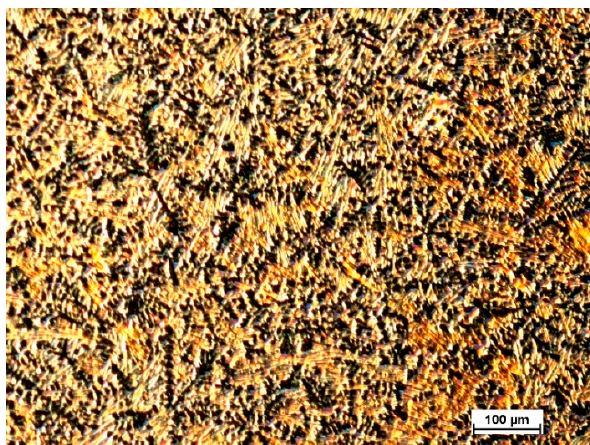
Figure 2. Light microscope image of microstructure revealed after etching in 2% nital solution for Mg 72 Zn 24 Ca 4 bulk material sample—before the melt spinning process.